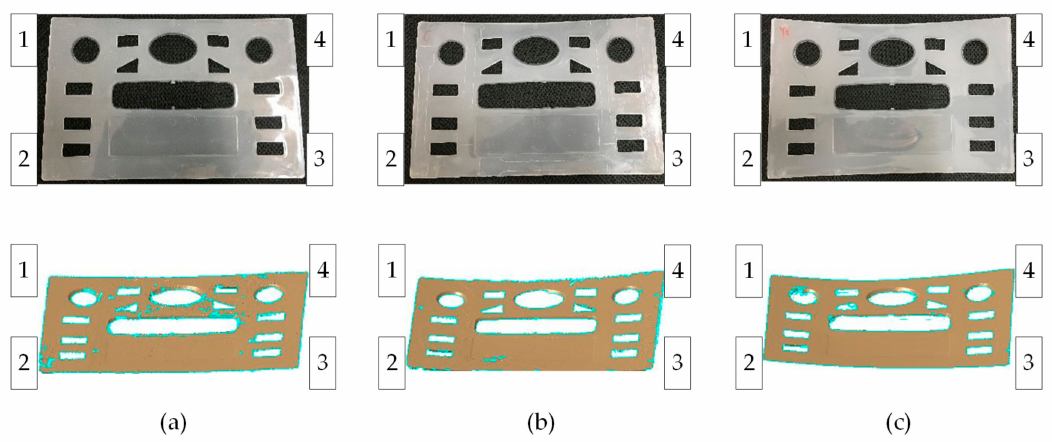
Figure 9. Warpage information of real parts measured by a 3D laser scanner under different molding conditions: ( a ) CIM, ( b ) RHCM60, ( c )